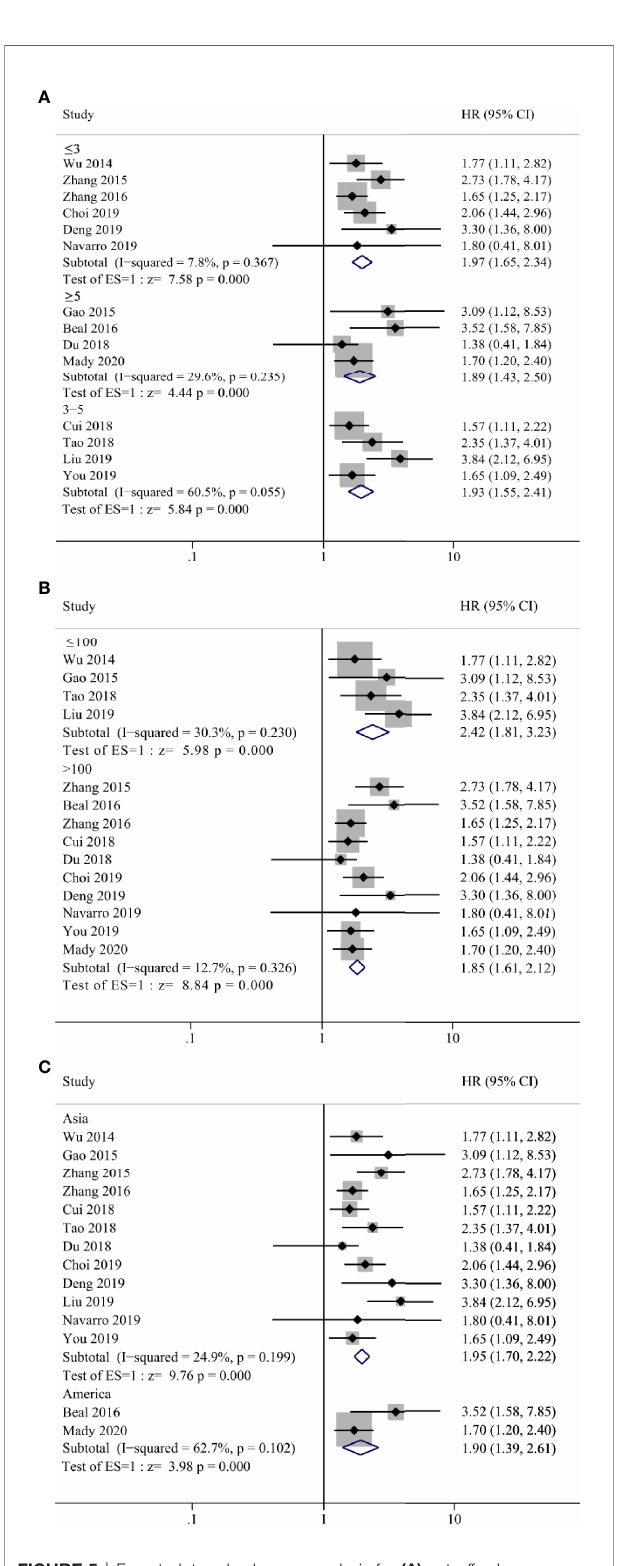
FIGURE 5 | Forest plot and subgroup analysis for (A) cut-off value, (B) sample size and (C) geographic area of the correlation between neutrophil – lymphocyte ratio (NLR) and overall survival of patients with Gallbladder carcinoma (GBC).